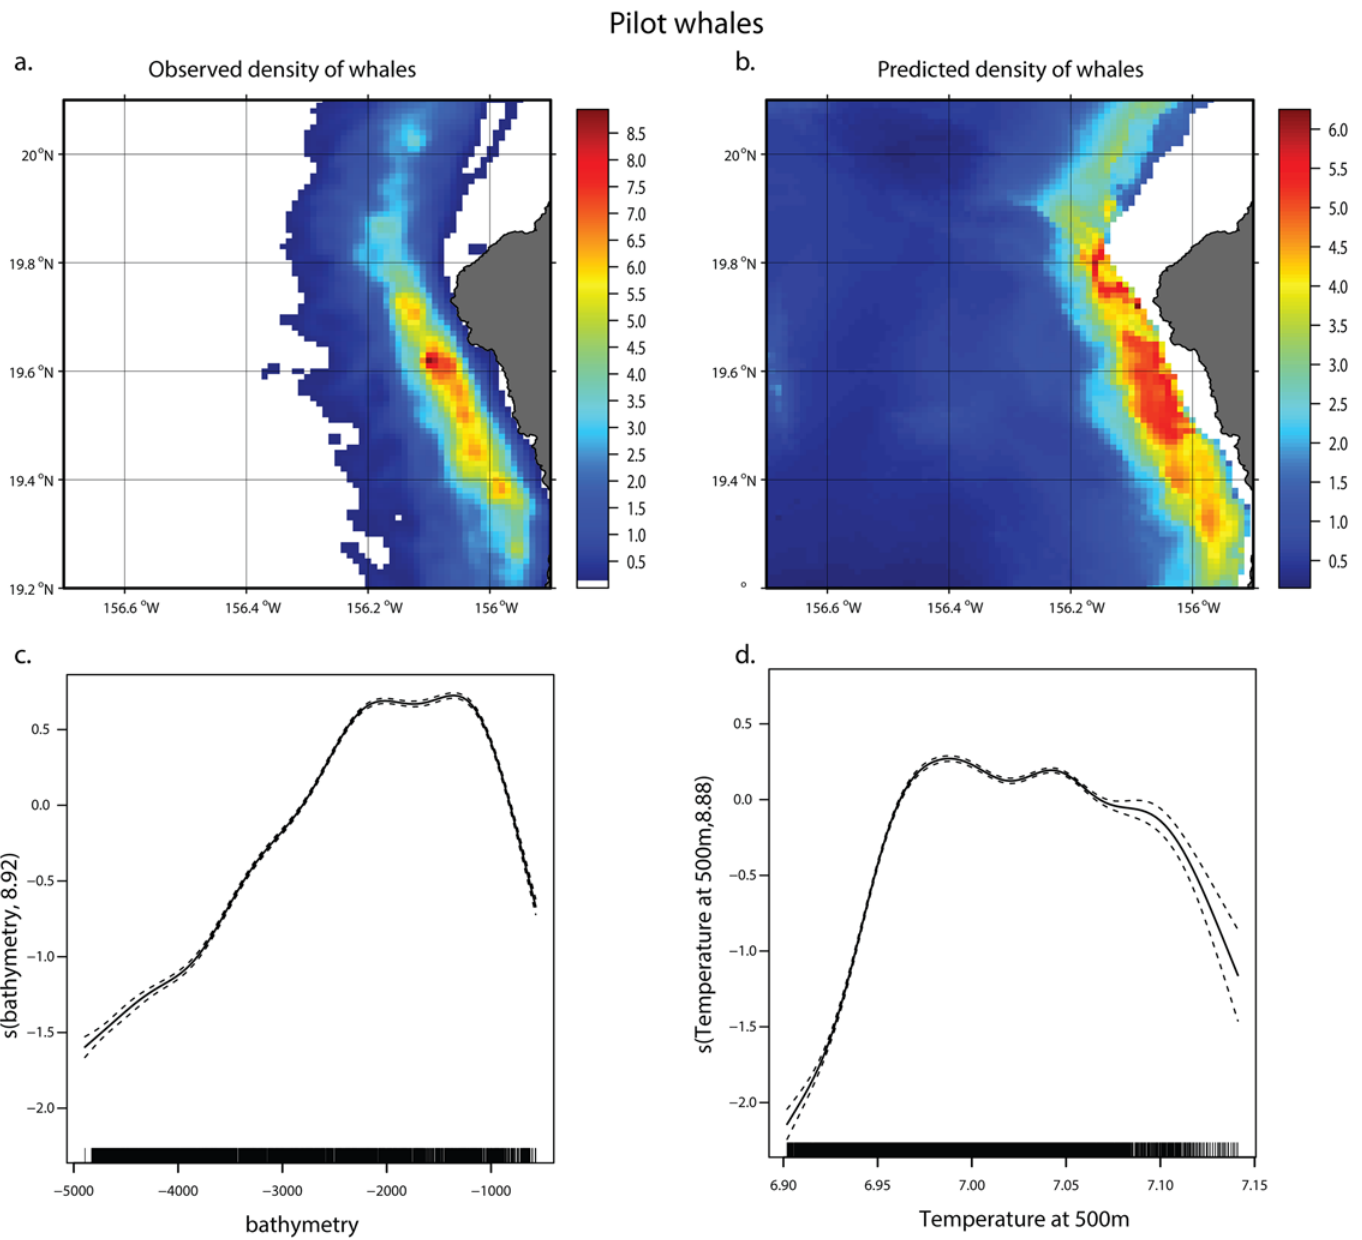
Fig 7. Pilot whale GAMM. Kernel density estimates for short-finned pilot whale (a), predicted short-finned pilot whale density from GAMM (b), smoother from GAMM for bathymetry (c), temperature at 500 m (d). The two scales are not the same to better reflect where the areas of relative highest densities are, according to the density estimates and the model predictions. Dashed lines represent the confidence intervals around the